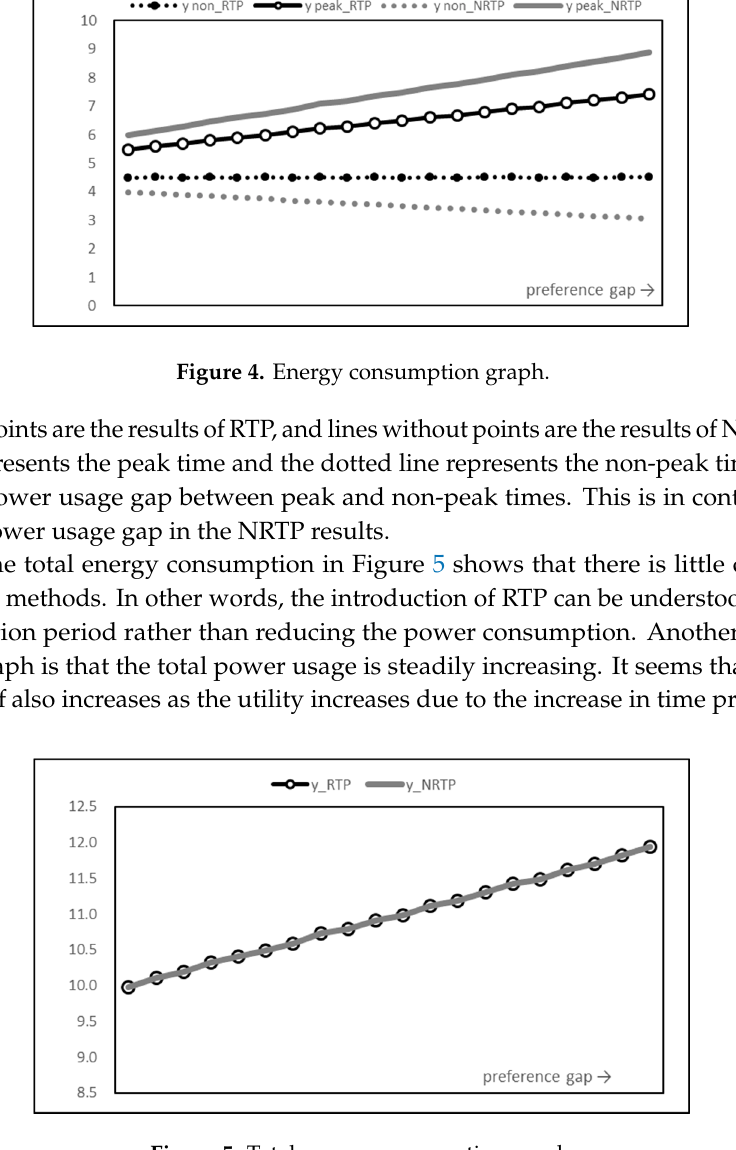
Figure 6. Peak-to-average ratio (PAR) graph. Figures 7 and 8 show the change in utility. A pattern similar to the result of previous consumption is found. As the time preference coefficient value of the peak time increases, the overall utility value increases steadily. The introduction of RTP rarely changes the overall utility but rather reduces it very little. The introduction of RTP leads to a decrease in the utility of the peak time and an increase in the utility of the non-peak time, but the balancing effect of the utility is small compared to that of consumption.